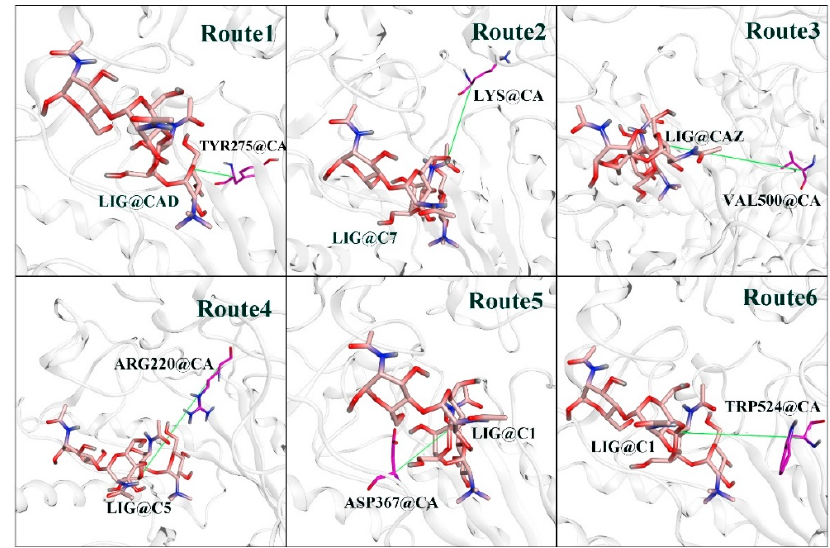
Figure 4. The unbinding direction of all routes in SMD simulations. Route 1: from the C α atom of Lys273 to the C7 atom of the ligand; Route 2: from the C α atom of Val500 to the CAZ atom of the ligand; Route 3: from the C α atom of Val500 to the CAZ atom of the ligand; Route 4: from the C α atom of Agr220 to the C5 atom of the ligand; Route 5: from the C α atom of Asp367 to the C1 atom of the ligand; Route 6: from the C α atom of Trp524 to the C1 atom of the ligand.